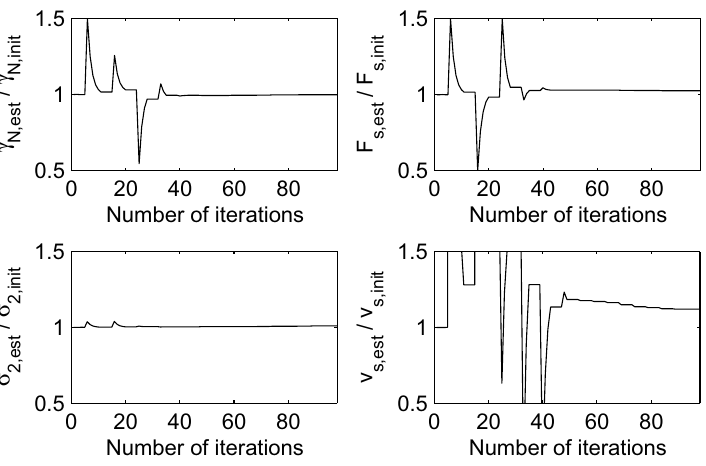
Fig. 11. Results from the identification of the LuGre friction model static parameters using the optimization-based algorithm. parameters. Again, the friction force was adjusted to obtain a clear representation of the bristles dynamics with the micro-slip oscillations. Figure 14 presents the acceleration and friction force signals obtained. By simply adjusting the parameter γ N , the friction phenomenon is once again accurately predicted. Changing the shaker had, in this case, the effect of modifying the normal force, and thus γ N